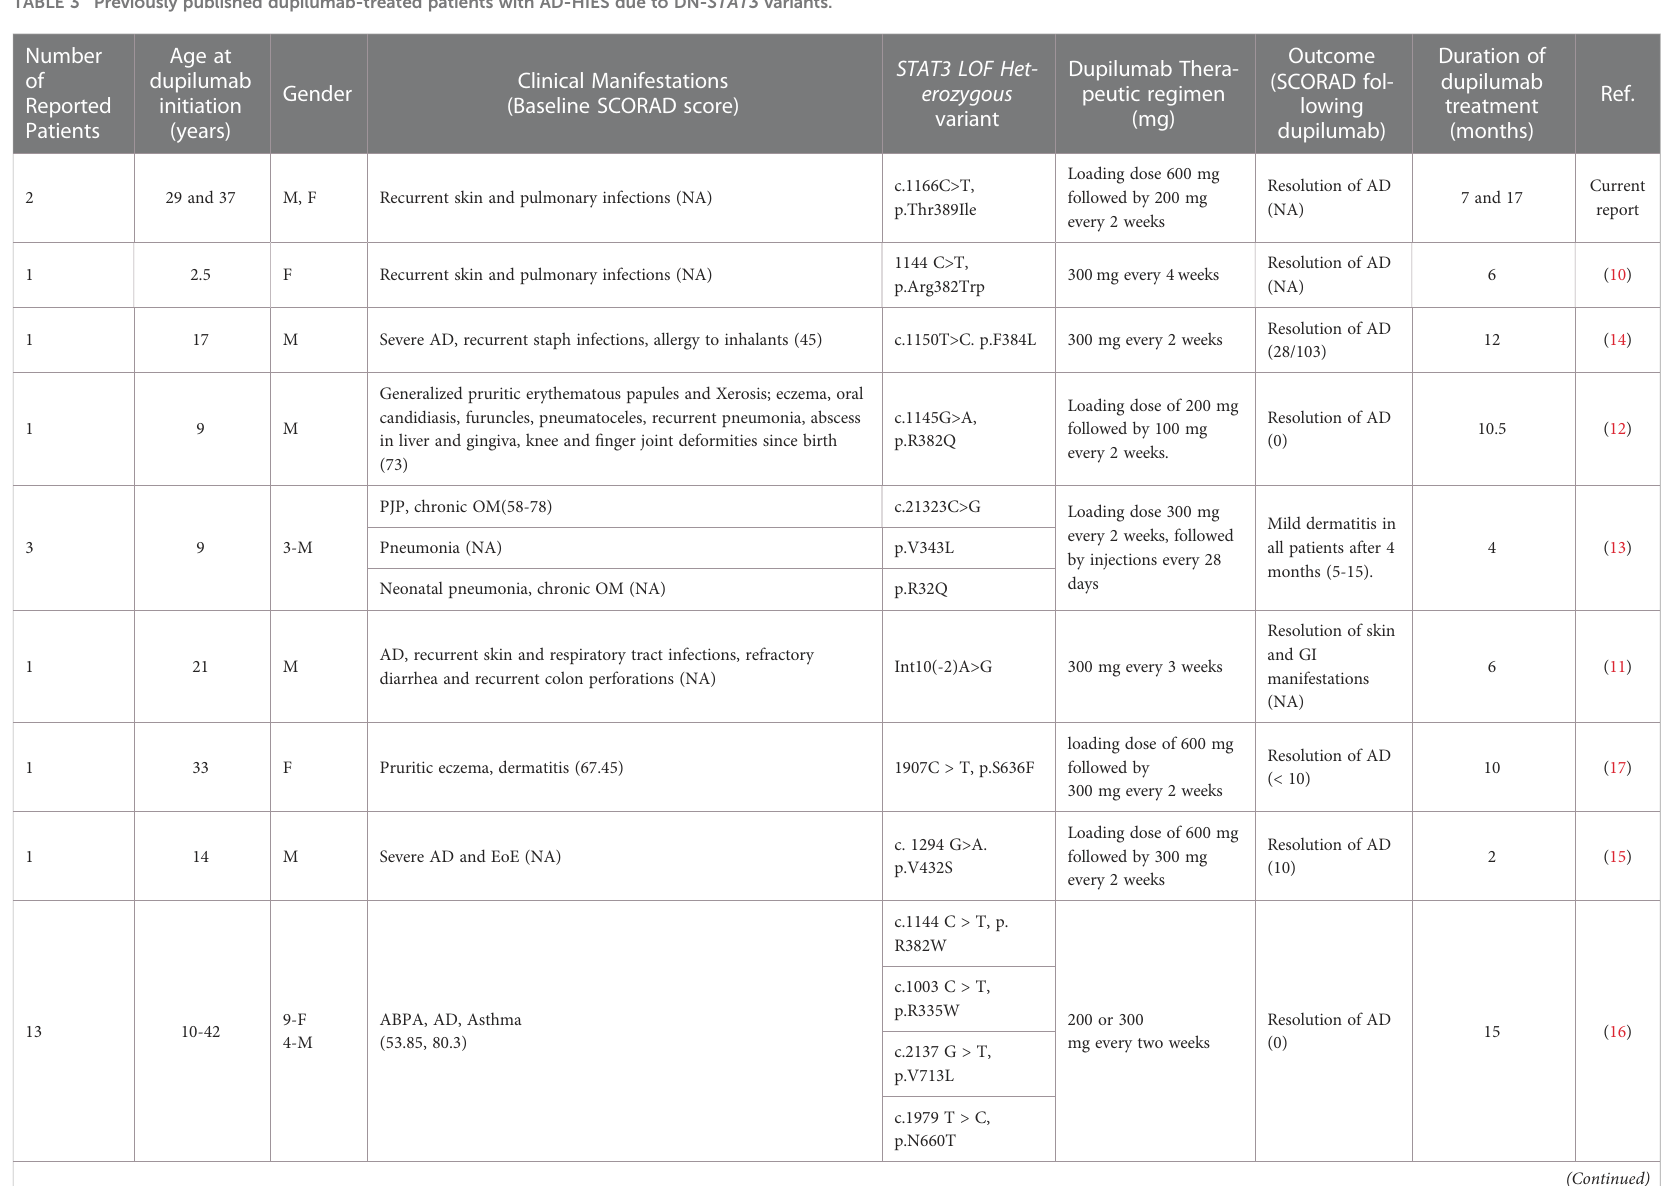
TABLE 3 Previously published dupilumab-treated patients with AD-HIES due to DN- STAT3